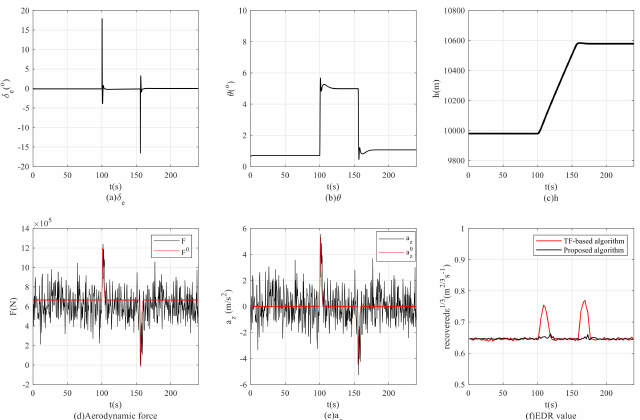
Figure 14. Eddy dissipation rate (EDR) calculation under elevator